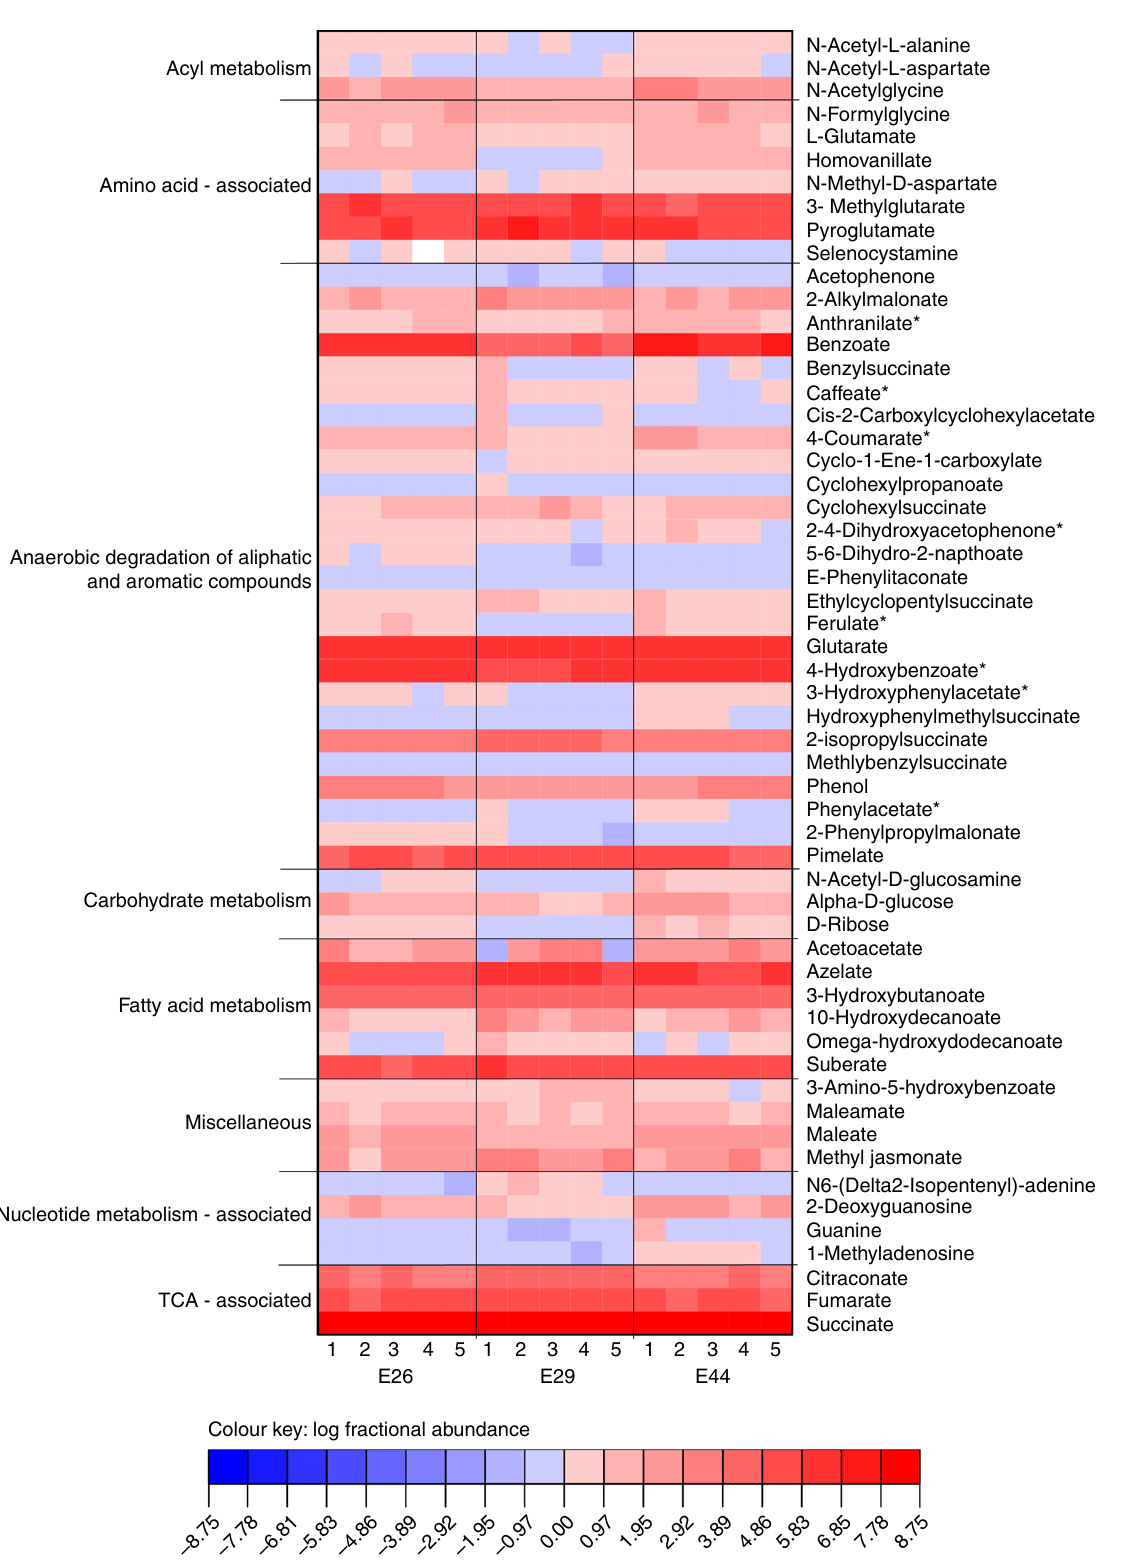
Fig. 4 Heatmap of metabolites identi fi ed in sediment pore water at Sites E26, E29, and E44. Metabolite levels were measured by LC-MS and observed intensities are expressed as the log fractional abundance. Technical replicate numbers ( n = 5) from each site are given on the bottom axis. Compound names are listed on the right axis and pathway assignments on the left. Compounds denoted with an asterisk can be intermediates in both anaerobic and aerobic metabolic